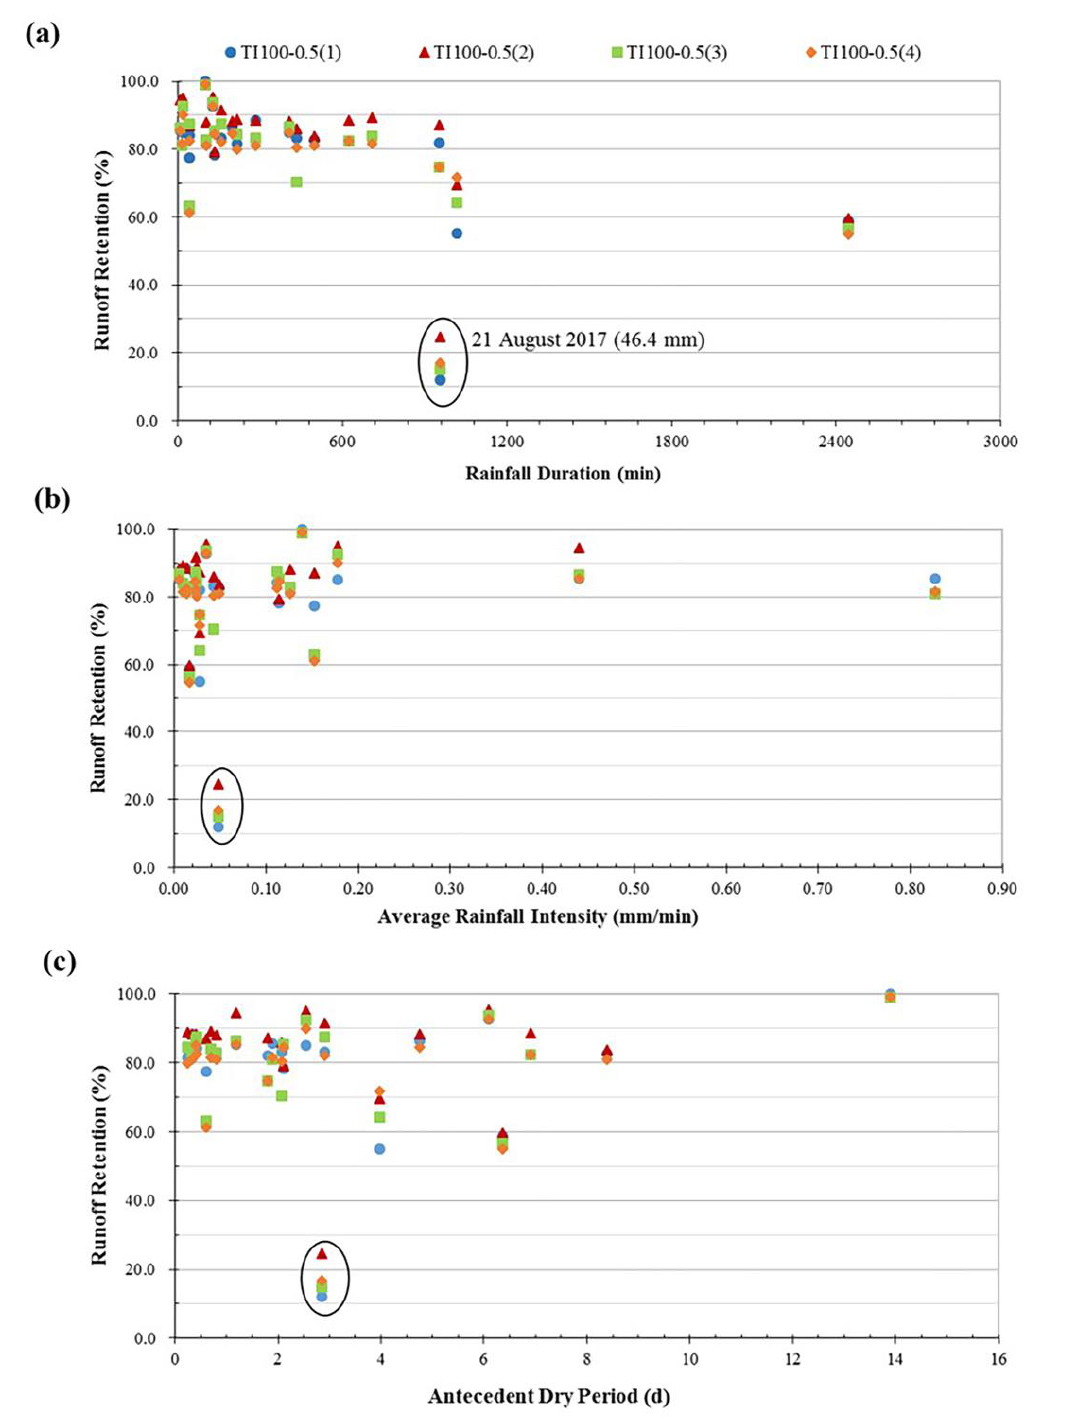
Figure 7. Rainfall retention rates for four TID100-0.5 EGR modules, for rainfall characteristics ( a ) rainfall duration; ( b ) average rainfall intensity; and ( c ) antecedent dry period.